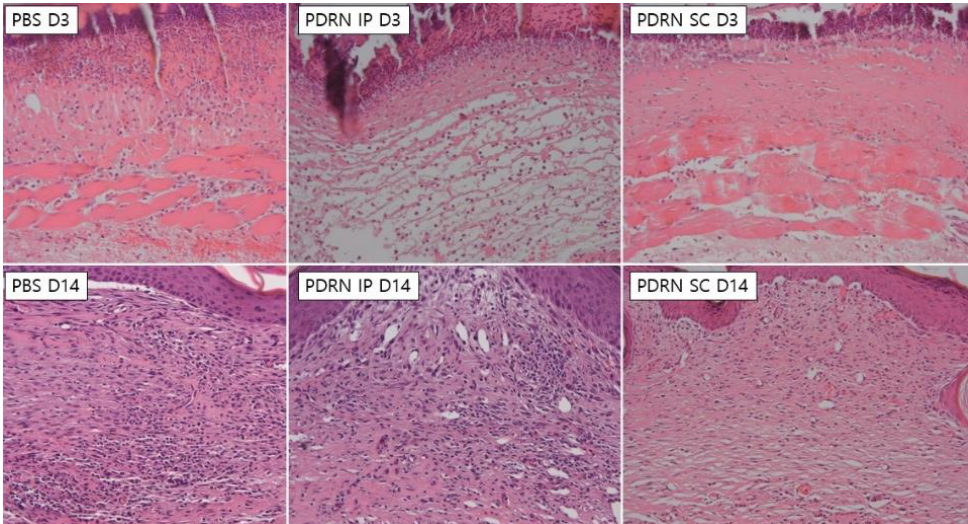
Figure 3. Histologic findings. In both the PDRN SC and the PDRN IP groups, there was a marked decrease in the number of inflammatory cells at 14 days as compared with 3 days. Moreover, at 14 days, the number of inflammatory cells was significantly smaller in both the PDRN SC and the PDRN IP groups as compared with the PBS group (hematoxylin and eosin, 200×). Table 2. Histologic scores.